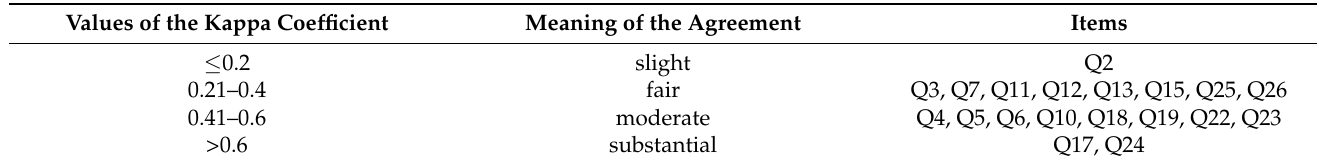
Table 3. Reliability of the questionnaire’s items according to Landis and Koch